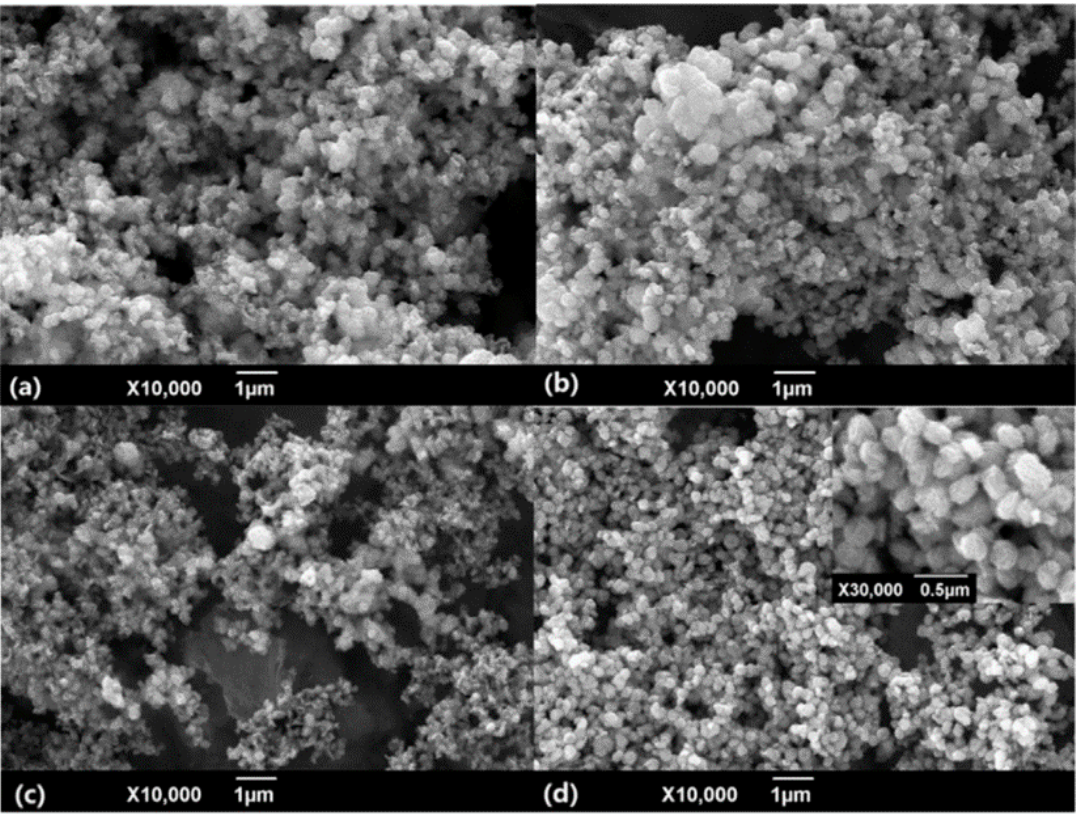
Figure 7. SEM images of MoS 2 microspheres prepared at 220 °C in pH 6 solution adding different surfactants (Mo/S ratio of 1:2): ( a ) no adding; ( b ) adding CTAB; ( c ) adding SDBS; ( d ) adding PVP [28]. Reprinted with permission from [28]. Copyright 2016. Elsevier.